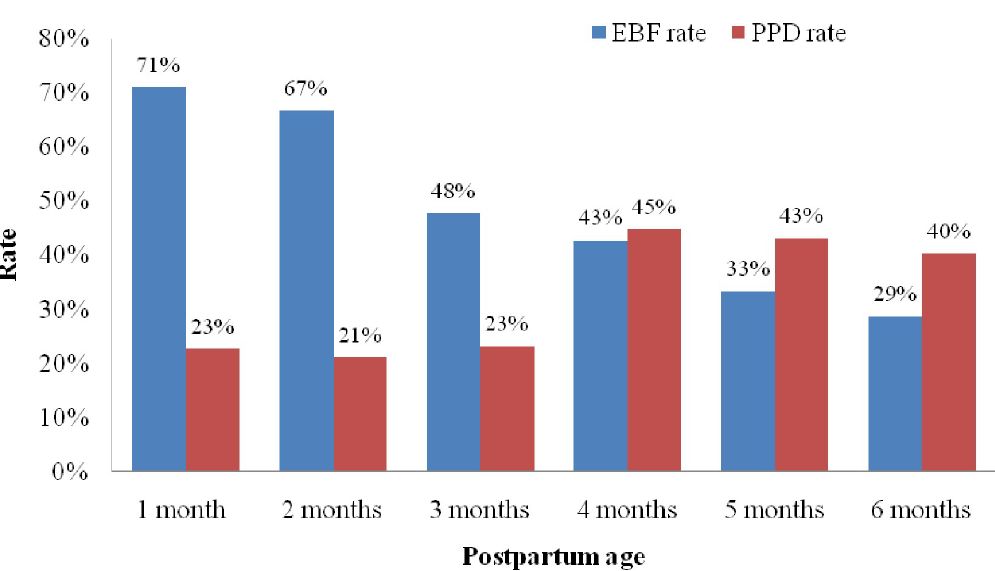
Fig 2. Rates of exclusive breastfeeding and PPD by maternal postpartum age.